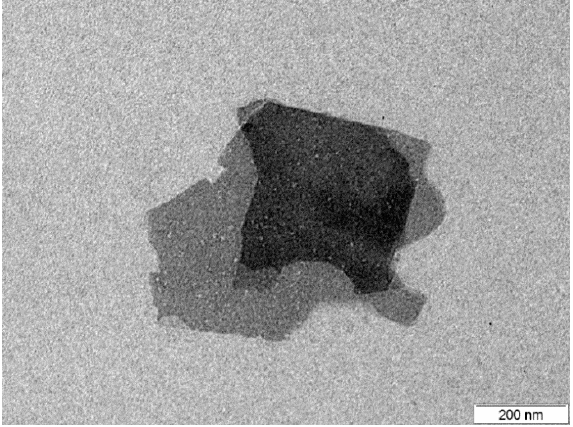
Figure 2. TEM image showing an example of the graphene flakes. Flakes consist of few graphene